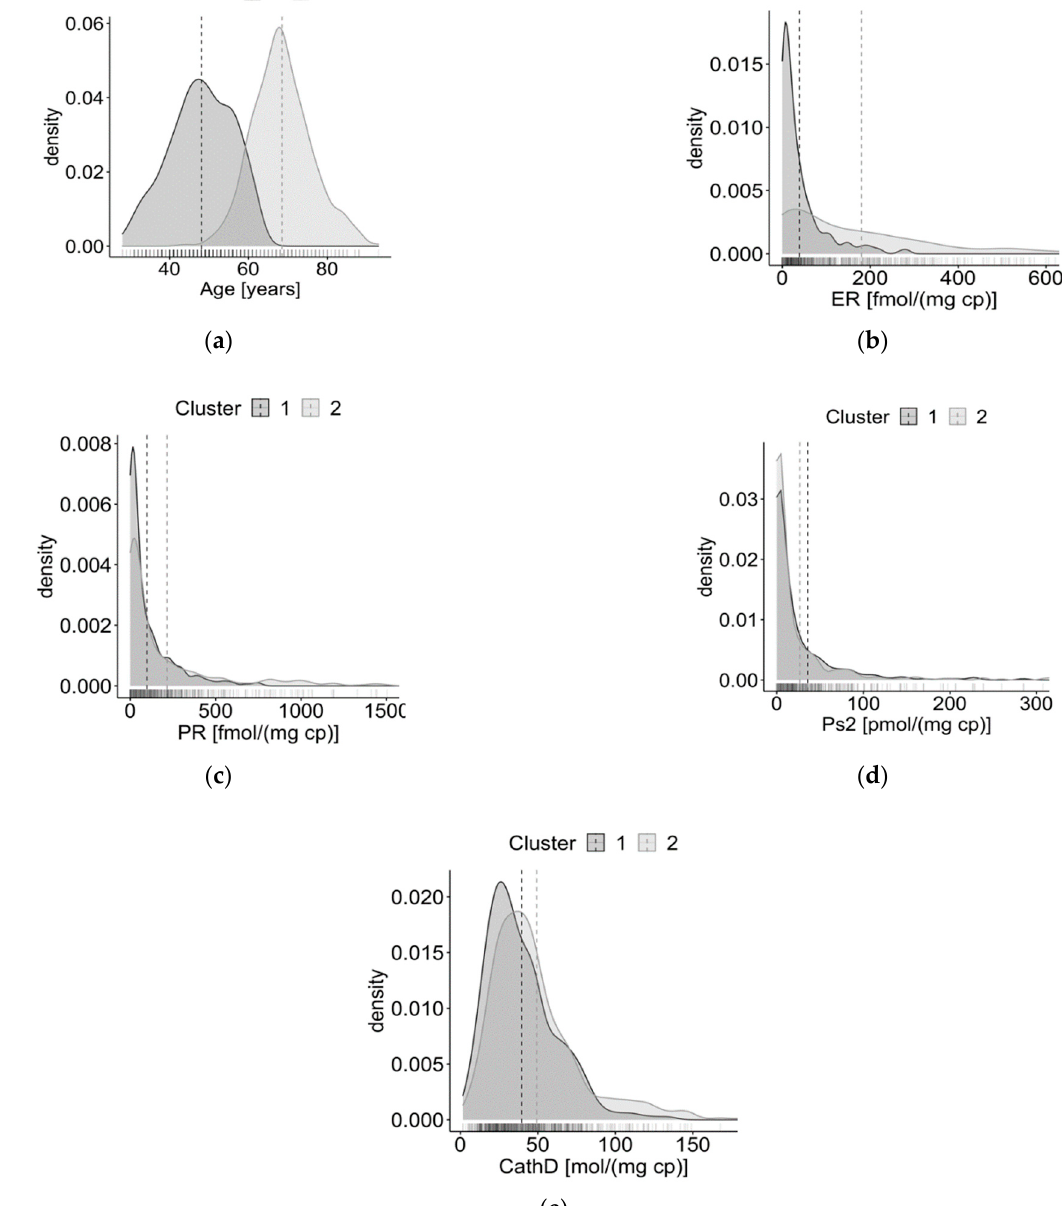
Figure 2. Density plots of the distributions of the variables in the two clusters obtained with the HAC algorithm. ( a ) Distributions of age; ( b ) distributions of oestrogen receptor (ER); ( c ) distributions of progesterone receptor (PgR); ( d ) distributions of pS2 protein; ( e ) distributions of cathepsin D.